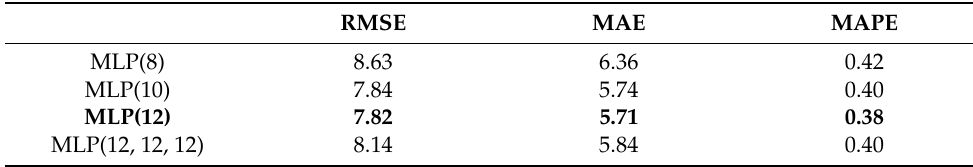
Table 3. Three-year forecasting performance obtained by various